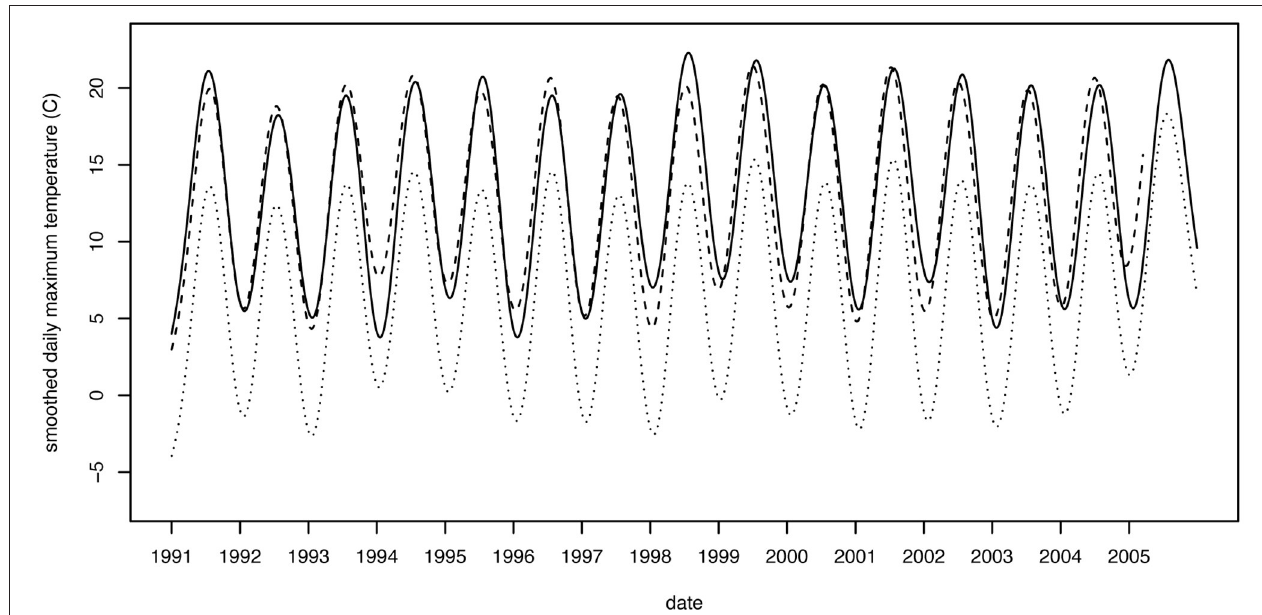
FIGURE 8 | Observed (solid), modeled (dotted), and bias corrected (dashed) modeled daily maximum temperatures for observational station 202423 (Oscoda, MI).